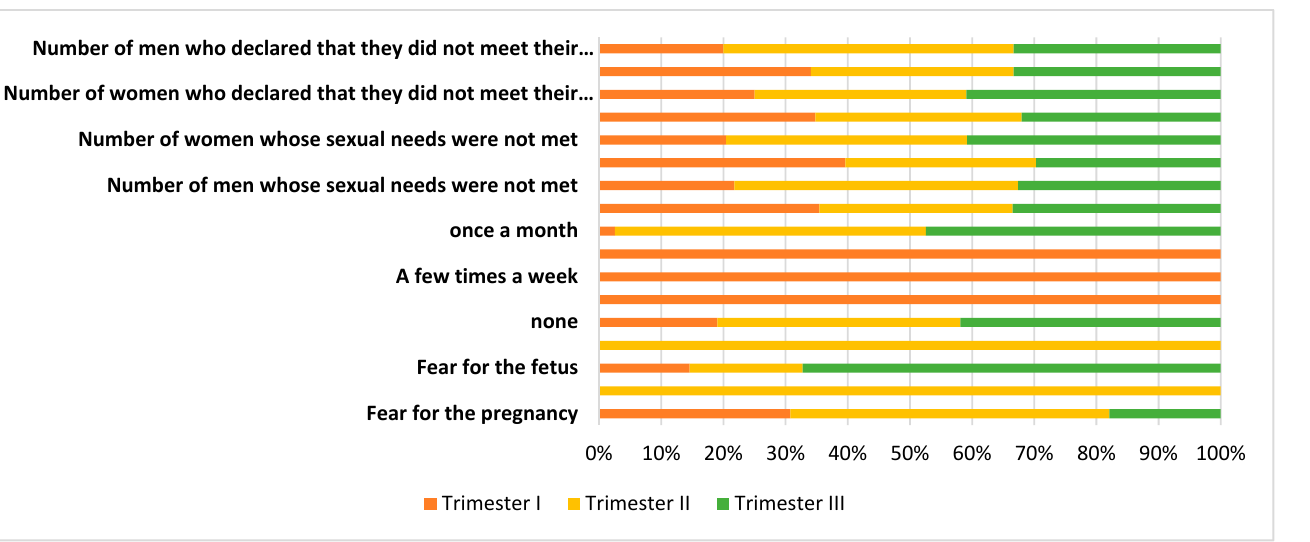
Figure 5. An 100% cumulative chart showing the reasons for sexual absenteeism, frequency of sexual activity and meeting the expectations of the couple in each trimester of pregnancy.